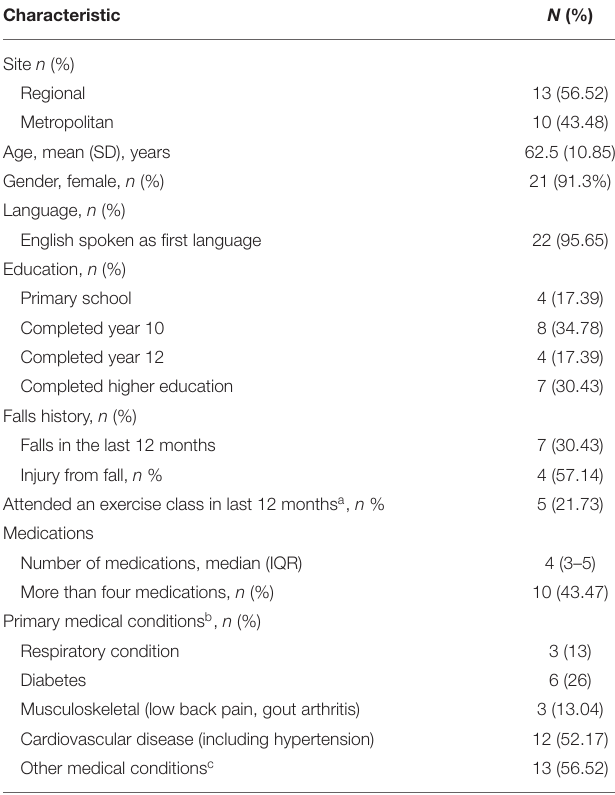
TABLE 1 | Participants’ characteristics ( n =